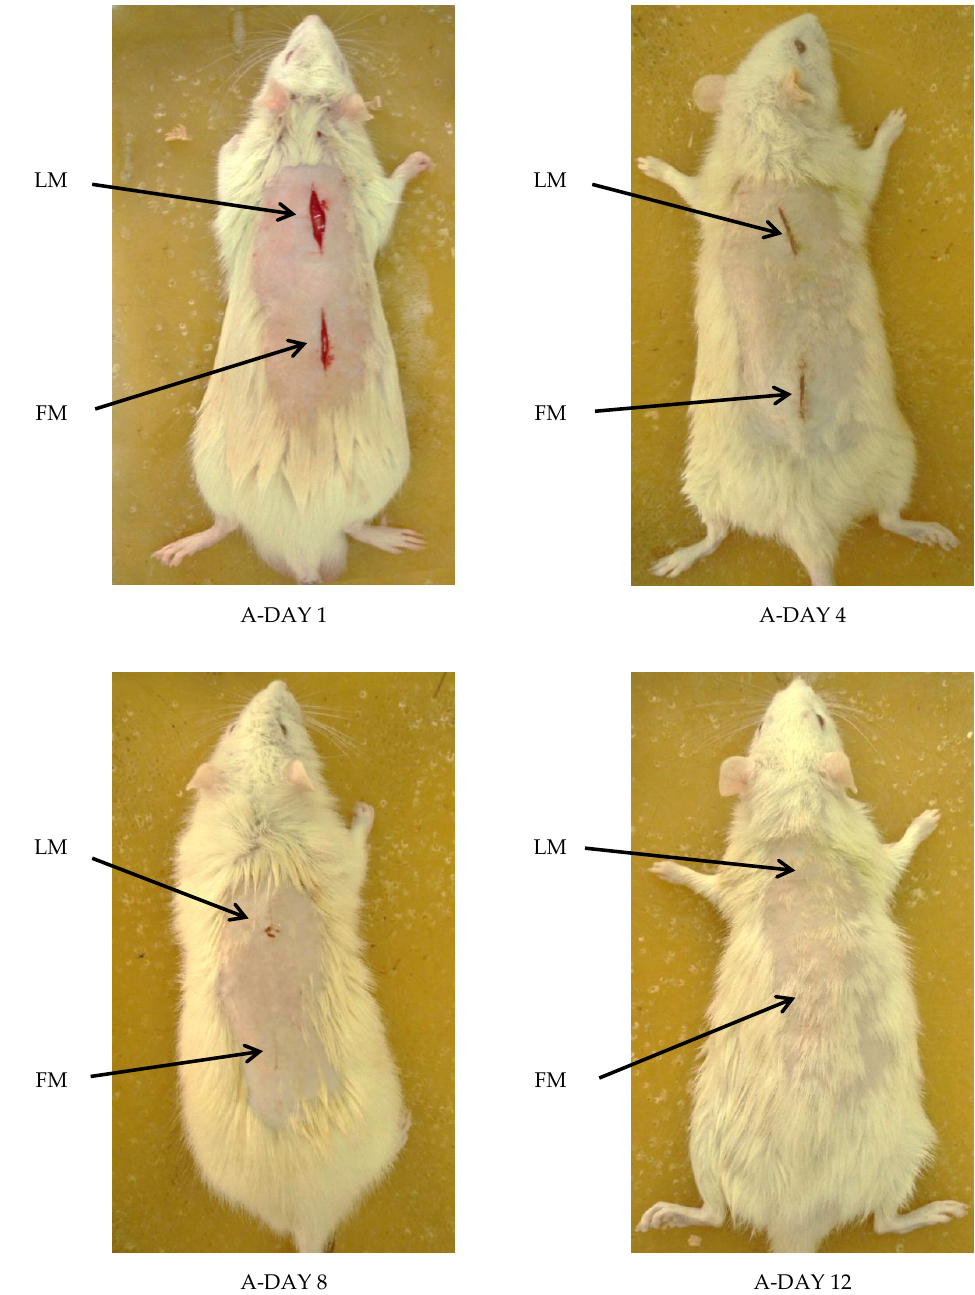
Figure 6. Visual examination of ACTIVE group rats at day 1, 4, 8, and 12, where the TOP wound represents the LM extract ointment, and the BOTTOM one represents the FM extract ointment.